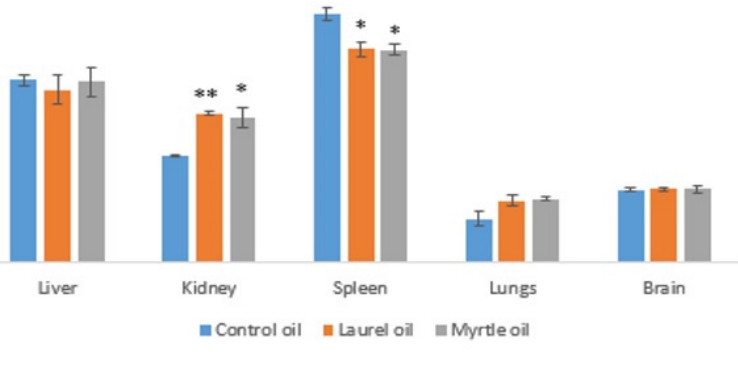
Figure 8. The effect of laurel and myrtle EO application on the oxidative stress biomarkers of the liver, kidney, spleen, lungs and brain tissues homogenates measured by the CAT activity ( A ), GSH ( B ) MDA ( C ) and carbonyl content ( D ). Female rats ( n = 5) were administered ig with laurel and myrtle EOs at a dose of 1 μ L per 1 g of rats once daily for 14 days. Laurel and myrtle EOs were mixed with sunflower oil (1:1) and the total daily volume per rat was 0.5 mL. The control group was treated ig with 0.5 mL of sunflower oil. The results are expressed as the mean value of each experimental group ± SEM. * Significantly different in relation to the control group (* p < 0.05; ** p < 0.01). ∇ Significantly different in relation to the laurel-EO-treated group ( ∇ p < 0.05). Abbreviations: CAT,